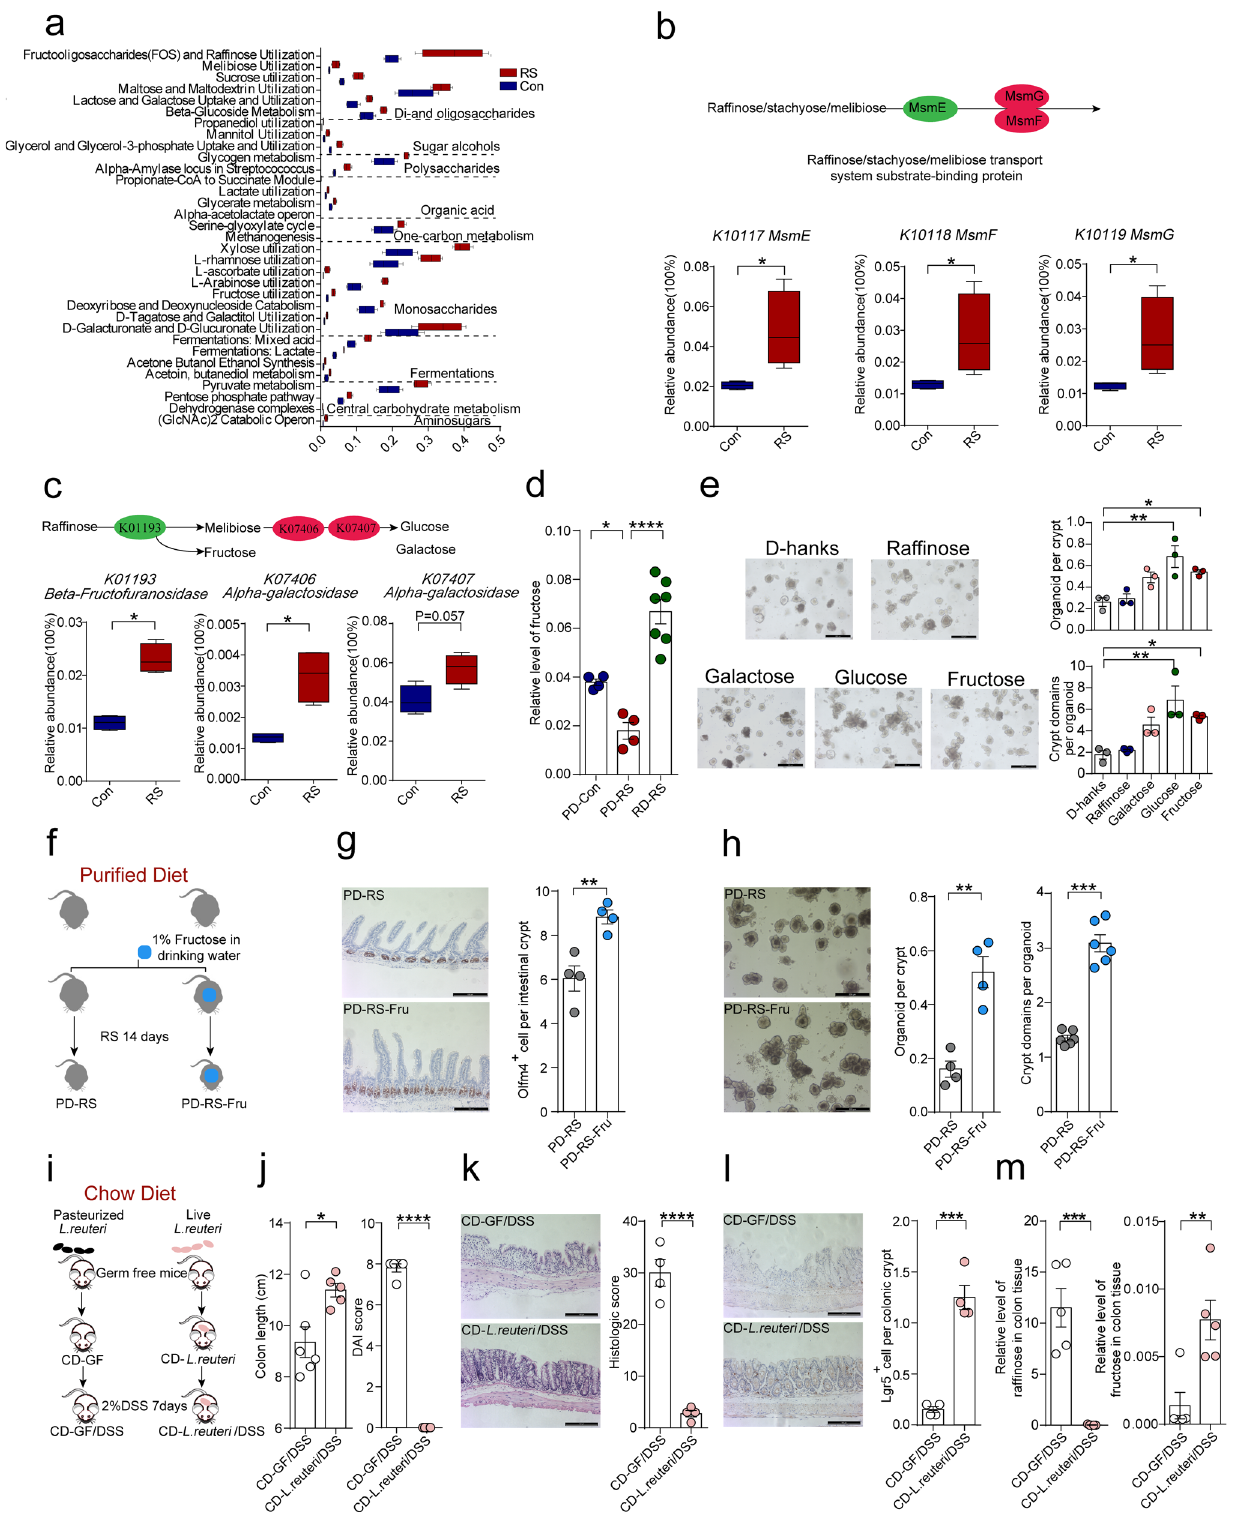
when PD was supplemented with raf fi nose, a signi fi cant increase of intestinal fructose in stressed mice could be observed, while glucose appeared not to change and galactose was negligible (Fig. 5d and Supplementary Fig. 5f). Indeed, we further observed that in vitro incubation of raf fi nose (10 mM) with L. reuteri